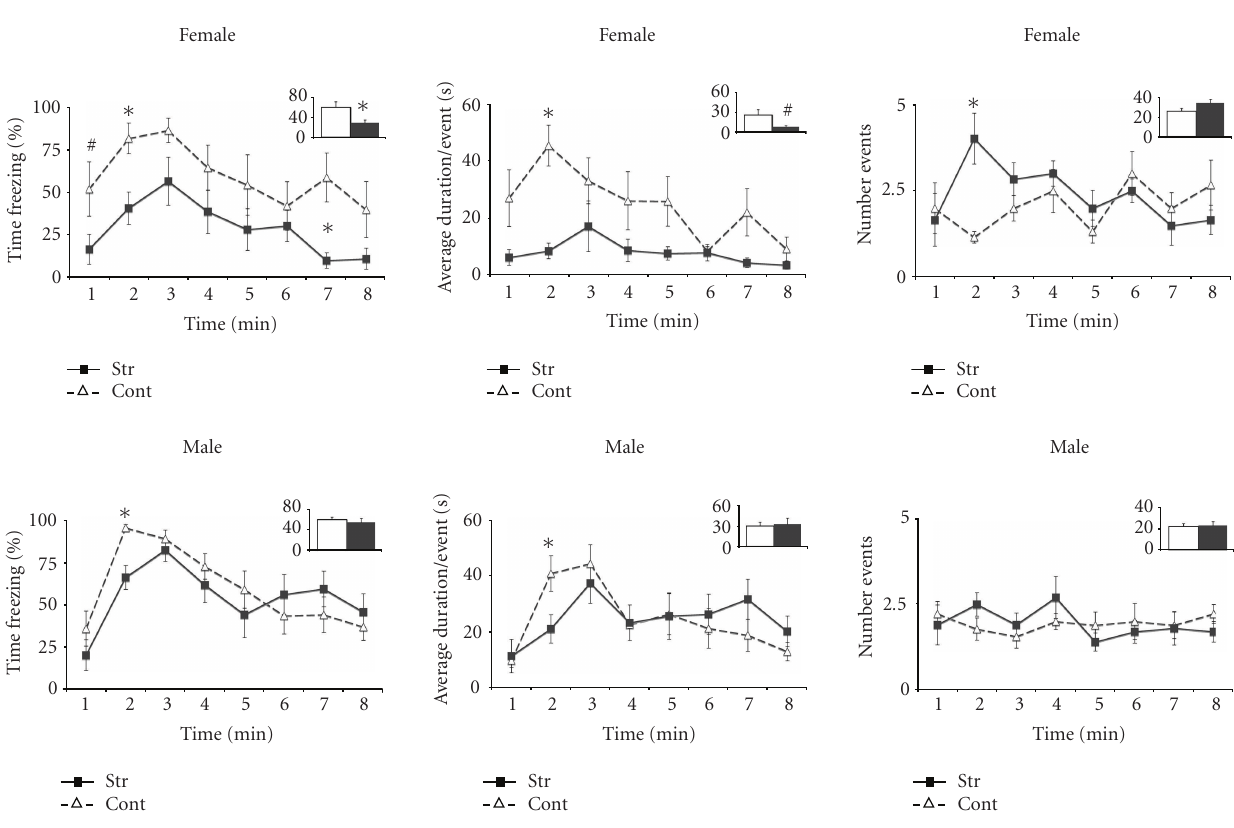
Figure 2: Contextual fear conditioning in adolescence. Mean percent freezing (left), average duration of freezing events (middle), and number of freezing events (right) ( ± SEM) on successive 1 minute blocks during reexposure to the conditioned context in female (upper panel) and male (lower panel) rats that had been submitted to stress prior to the onset of puberty (filled squares) or control animals (open triangles). Within these figures, the total freezing value (percentage, average duration, or number) during the entire test is represented as bars in the inserts. ∗ P < . 05, # P < . 05 < .